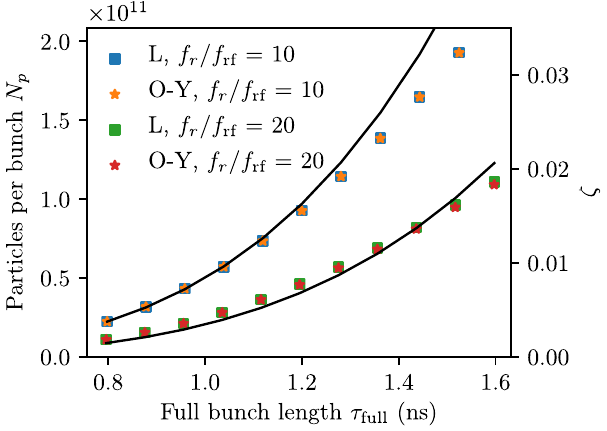
FIG. 6. The LLD intensity threshold as a function of the full bunch length τ calculated with MELODY using the Lebedev full equation (squares) and the Oide-Yokoya method (stars) and analytical Eq. (55) (lines) for a broadband resonant impedance with Im Z=k ¼ 0 . 07 Ω , Q ¼ 1 and two different values of the resonant frequency f ; η > 0 , V 0 ¼ 6 MV and μ ¼ 2 . The r corresponding intensity parameter ζ is shown on the second vertical axis.